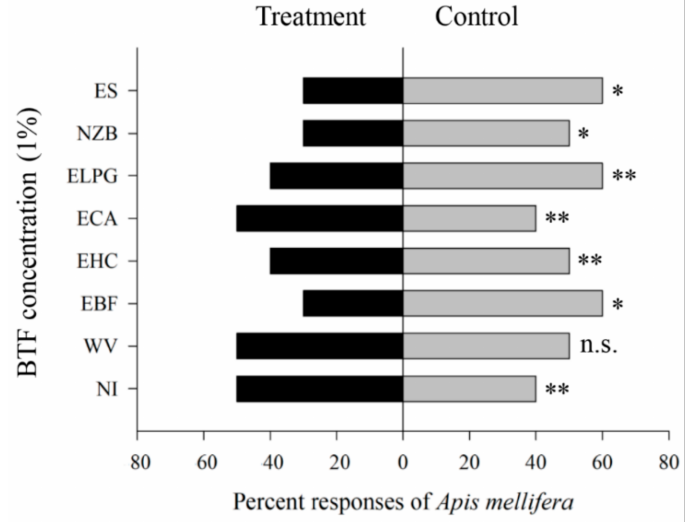
Figure 4. Olfactory responses of Apis mellifera to odors of various BTF components (1.0%) versus clean air in a Y-tube olfactometer. Ten adult worker bees were tested for each component of BTF. Asterisks indicate significant differences: * p < 0.05 and ** p < 0.01 (Fisher’s exact test). “n.s.” indicates no significant difference between the treatment and control ( p > 0.05; Fisher’s exact test). ES, extract of seaweed; NZB, nitrogen, zinc, boron; ELPG, extract of low quality fresh Panax ginseng ; ECA, extract of Chenopodium ambrosioides ; EHC, extract of Houttuynia cordata ; EBF, extract of Bupleurum falcatum ; WV, wood vinegar; NI, inert